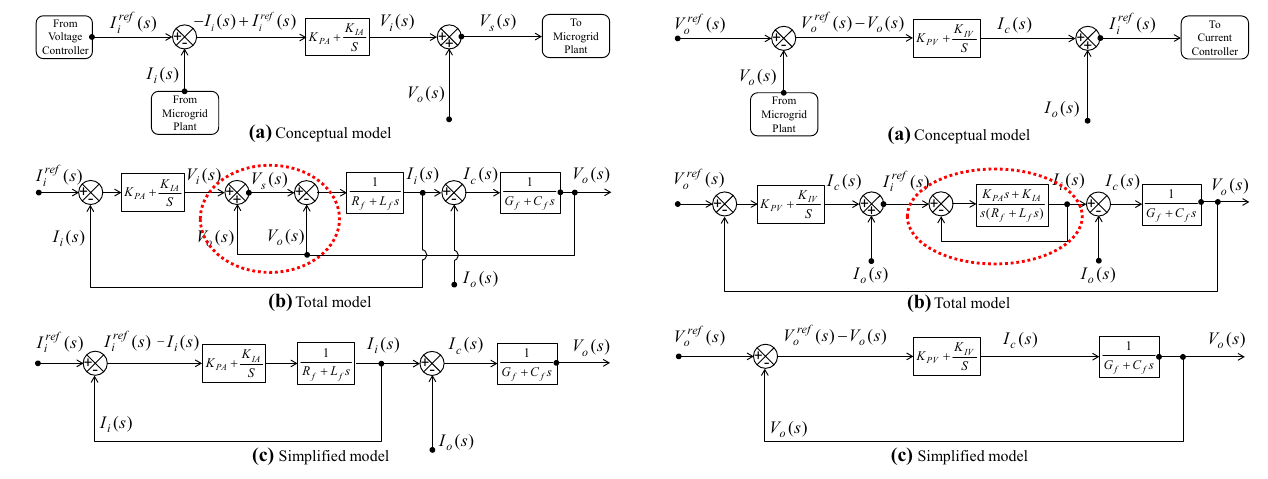
Fig. 6 Model of the current controller of the RESM plant Fig. 7 Model of the voltage controller of the RESM plant